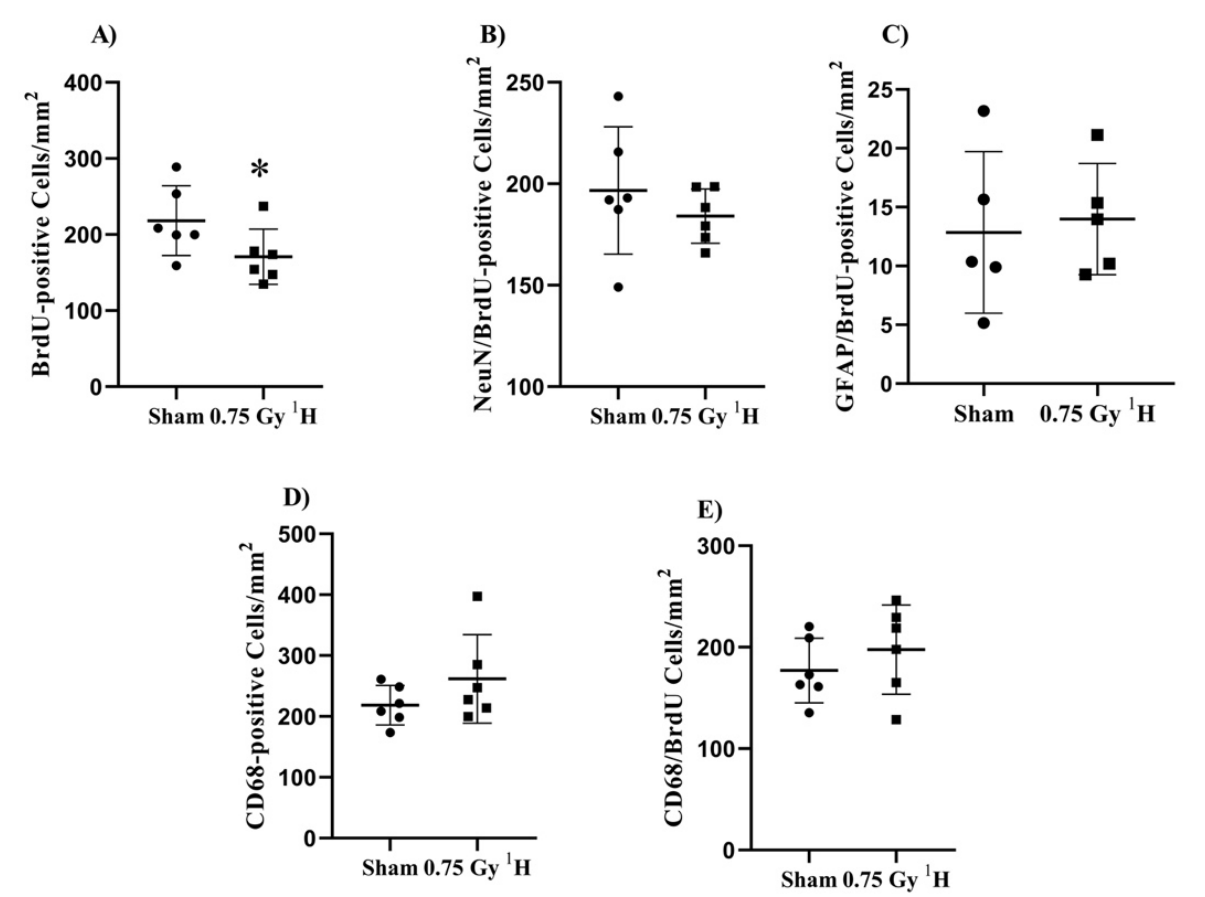
Figure 7. ( A ) Newly born cells. There was a significant difference in the numbers of BrdU + cells in the fractionated 1 H-irradiated mice compared to sham-irradiated mice (* p < 0.05). ( B ) Newly born neurons (NeuN + /BrdU + ). There were no significant differences in the numbers of cells/mm 2 between groups ( p = 0.40) 1 H-irradiated mice (N = 6) compared to sham-irradiated mice (N = 6). ( C ) Newly born astrocytes (GFAP +/ BrdU + ). There were no significant differences in the numbers of newly born astrocytes between groups ( p = 0.69). ( D ) Activated microglia (CD68 only). There were no signifi- cant differences in the total numbers of activated microglia between groups ( p = 0.07). ( E ) Newly born activated microglia (BrdU + /CD68 + ). There were no significant differences in the numbers of newly born activated microglia between groups ( p = 0.15).